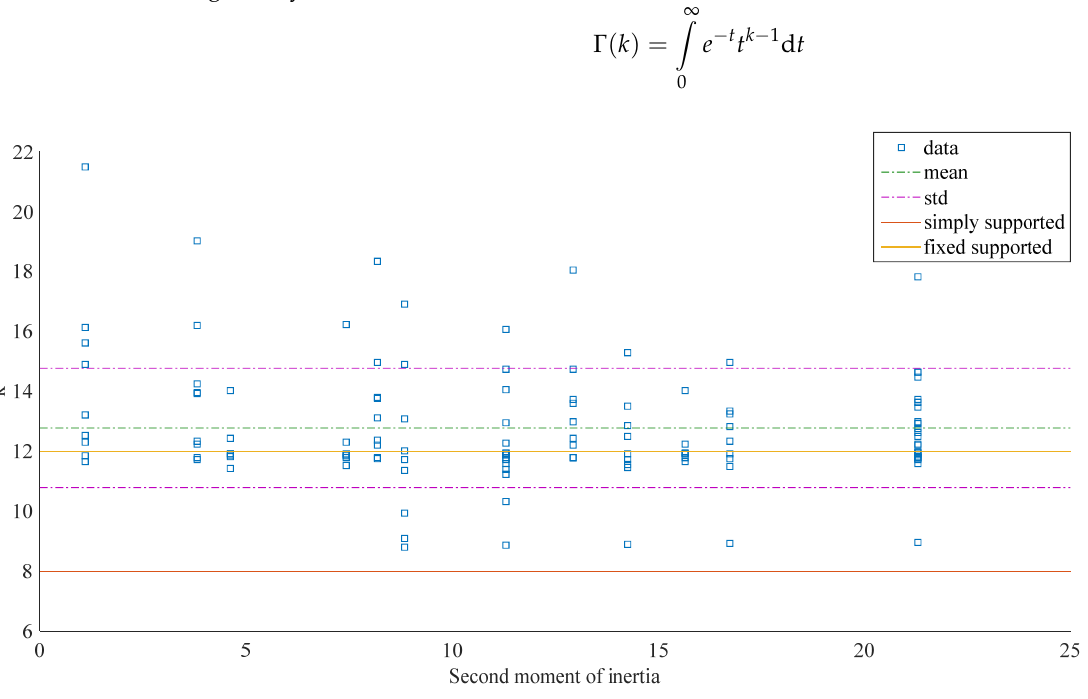
Figure 11. Results of k in relation tothe second moment of inertia of transverse stiffeners.